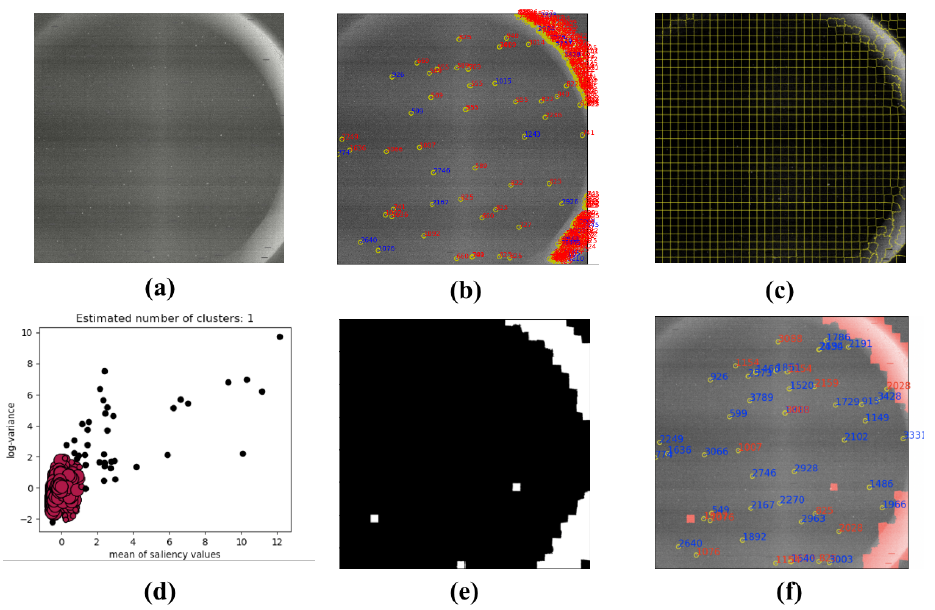
Figure 19. Regular annulus interference: ( a ) the star image with regular annulus interference; ( b ) the extraction result with W-LOF (there are many false star spots); ( c ) the result of SLIC segmentation; ( d ) the result of DBSCAN clustering; ( e ) binary mask generated by proposed method; and ( f ) the result of star spot extraction only in the sky region.